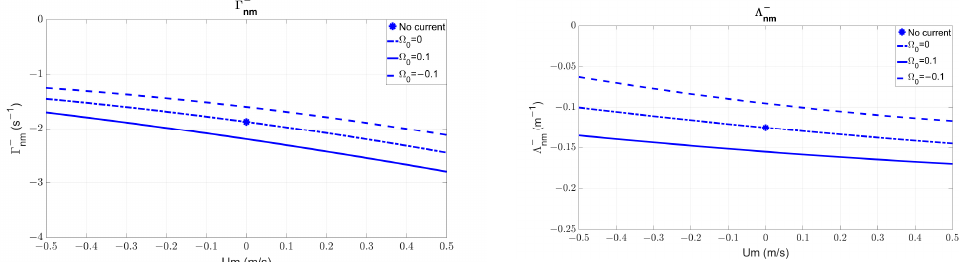
Figure 11. Γ (stream function coefficient) and Λ (surface elevation coefficient) of the nm-negative Figure 11. 𝛤 (stream function coefficient) and 𝛬 (surface elevation coefficient) of the nm-negative interaction component as functions of current velocity at the interaction component as functions of current velocity at the mid-depth.